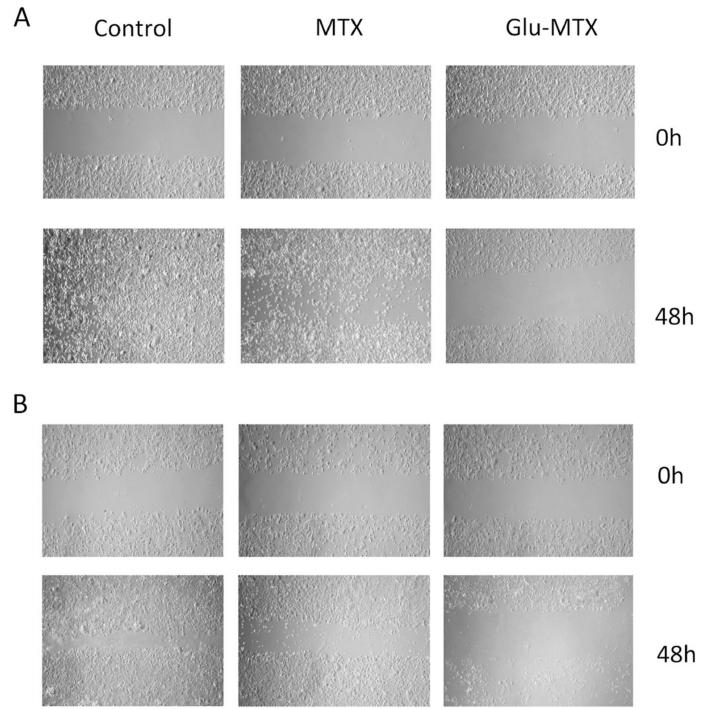
Figure 3. Wound-healing assay at time point 0 and after 48 h of incubation with 10 µ M of MTX and Glu-MTX. Results show that after 48 h, the scrap in control cells is fully coated by cells, whereas in MTX-treated samples, the scrap is smaller compared to samples incubated with Glu-MTX, where no migration of cells is observed. ( A ) Representative images of SW480 cells. ( B ) Representative images of MCF-7 cells. 10 × objectives were used to capture the photographs.